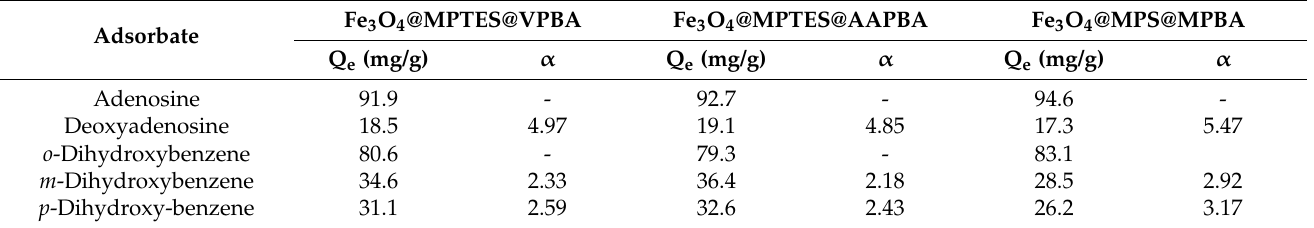
Table 2. Absorption capacity (Q e ) and selectivity factor ( α ) of different adsorbates by Fe 3 O 4 @PBA nanoparticles.